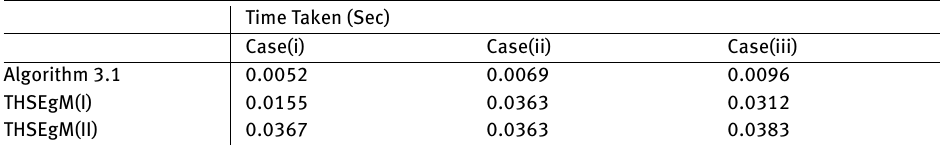
Table 1: Comparison of Algorithm 3.1, THSEgM(I) 5 and THSEgM(II) 6 for Example